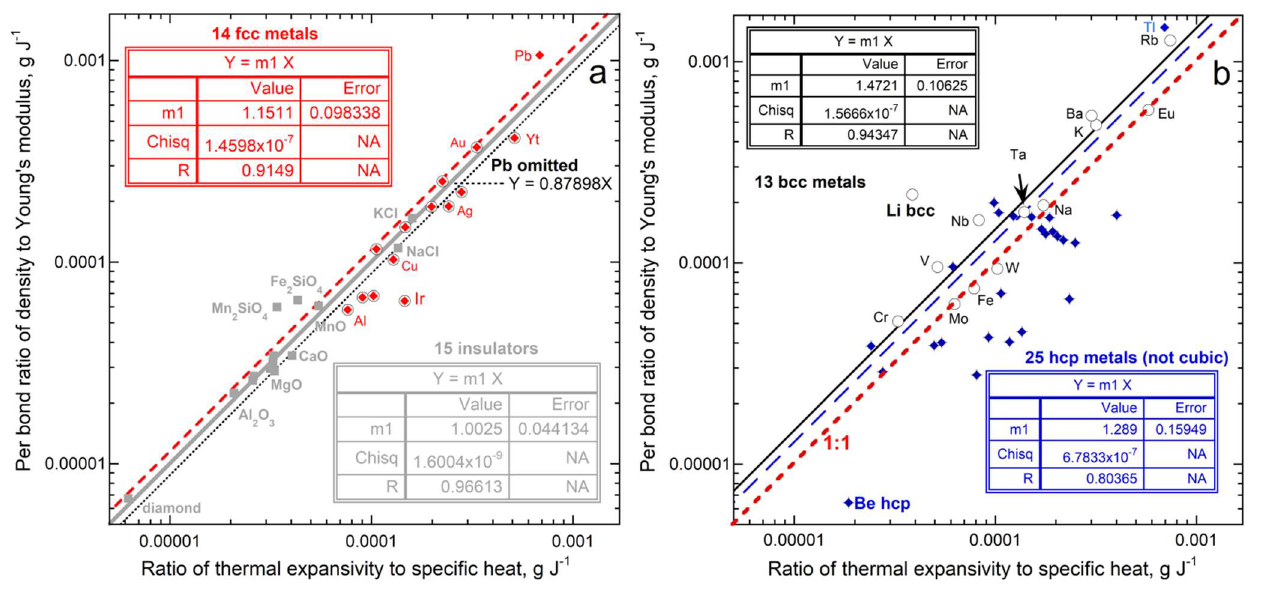
Figure 14. Dependence of α / c P on ρ /( Ξ N / Z ). Literature sources of data on elements are in Figure 13. For the insulators, tables of [54] were used, where Co 2 SiO 4 was omitted because α was estimated. Fits are least squares and are labeled with the number of solids in each category: ( a ) insulators and cubic fcc metals. Lead strongly influences the slope due to its softness, as shown by the two fits. Iridium has little influence as it is near a cluster of points. Orthorhombic Fe 2 SiO 4 has a shearing transition whereas α for orthorhombic Mn 2 SiO 4 is unconfirmed; ( b ) cubic bcc and hexagonal hcp metals. Outliers Li and Be have very small cations and few valance electrons.